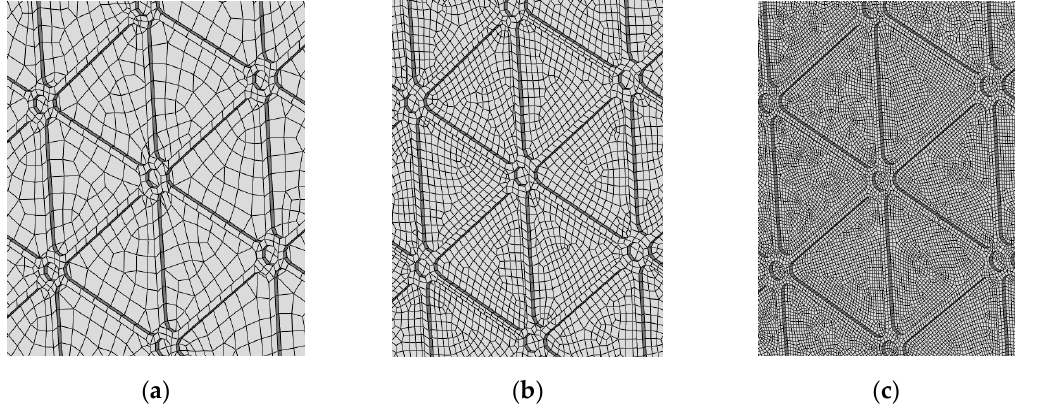
Figure 7. Mesh sizes chosen to perform the convergence study. Characteristic element length: ( a ) 5 mm, ( b ) 2.5 mm and ( c ) 1 mm.